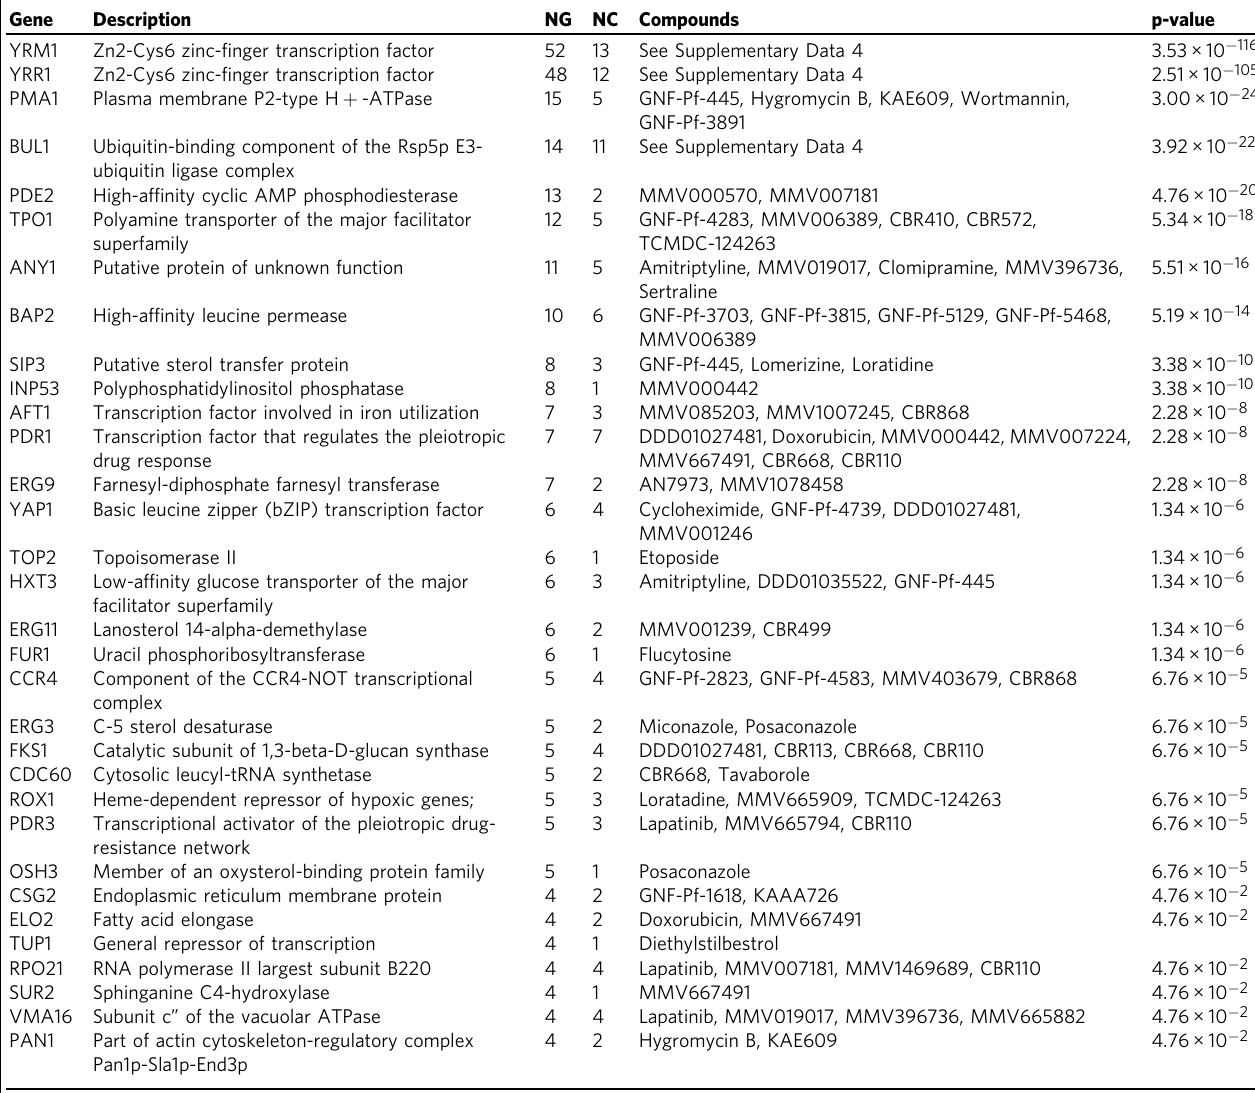
32 genes contained at least four independently selected coding mutations, the signi fi cance threshold for number of mutations occurring in a gene at a rate not expected by chance across the dataset. Bonferroni-corrected p -valueswerecalculatedusingthehypergeometricmeanfunction(numberofsuccessesinsample = numberoftimesgenewasidenti fi edasmutated;samplesize = totalnumberof genes mutated in dataset (731); successes in population = number of independent selections (355); population size = number of genes in yeast genome multiplied by 355) followed by Bonferroni- correction using number of independent selections.For a complete list of genes and mutations identi fi ed across the study, refer to Supplementary Data 4. NG number of times gene was identi fi ed as mutated in independent evolution experiments, NC number of